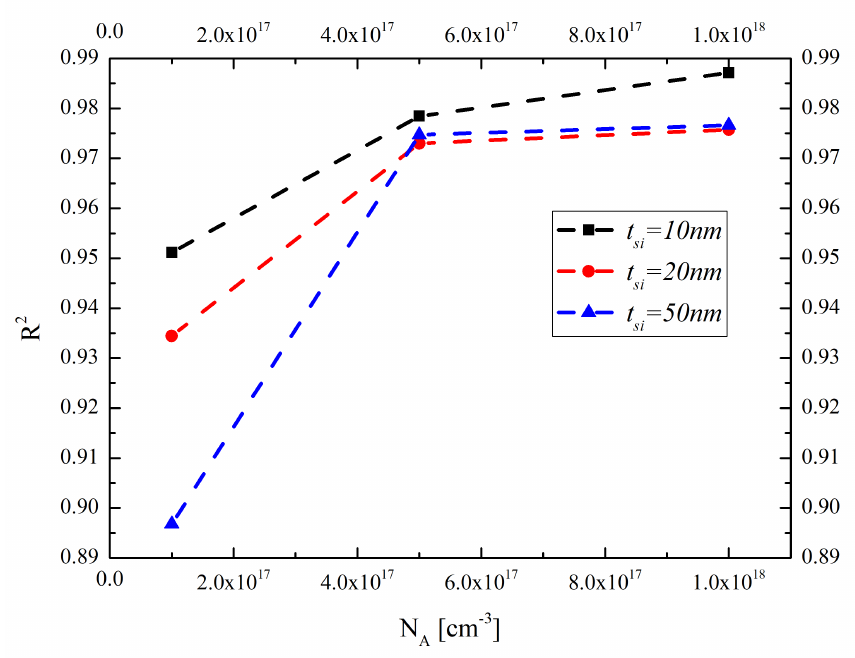
Figure 8. The influences of the doping concentration and the silicon layer thickness on fitting goodness of the thermal conductivity model considering the boundary scattering